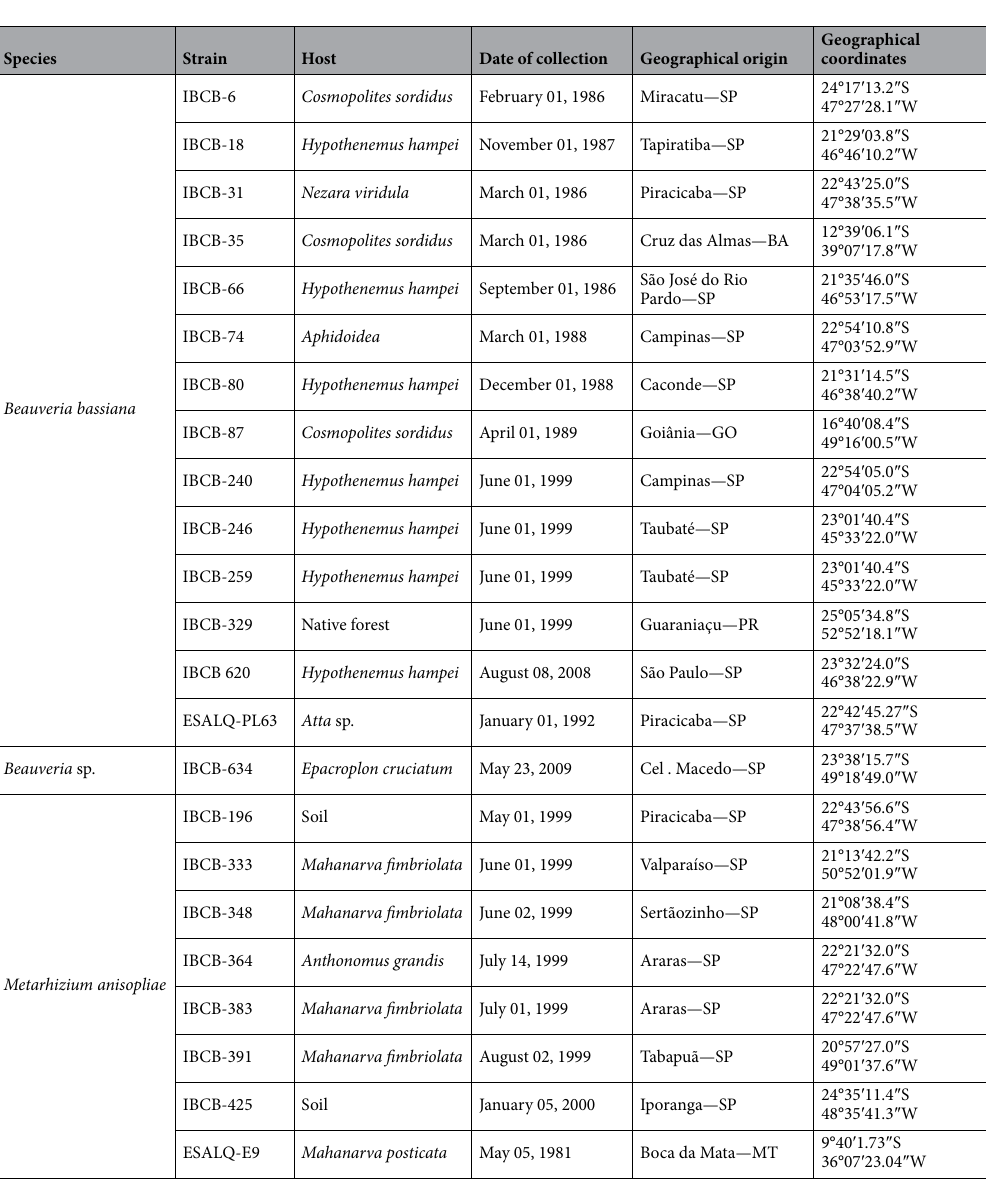
Table 2. Origin, date of collection, host and species of fungal strains native to Brazil used in this study. All fungal strains used in the current study are registered at the National System for the Management of Genetic Cardim Abreu” at the Experimental Center of the Instituto Biológico, Campinas, SP, Brazil, with a prefix code ‘IBCB’. Fungal strains ESALQ-PL63 and ESALQ-E9 are proprietary of Koppert do Brasil Holding